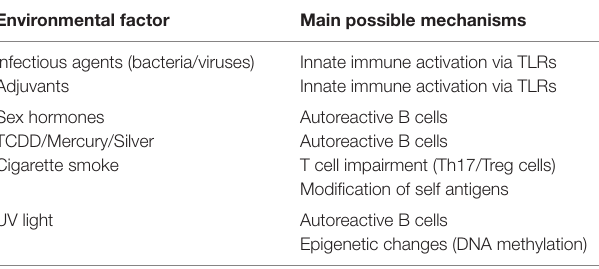
TABLe 2 | environmental factors and mechanisms involved in